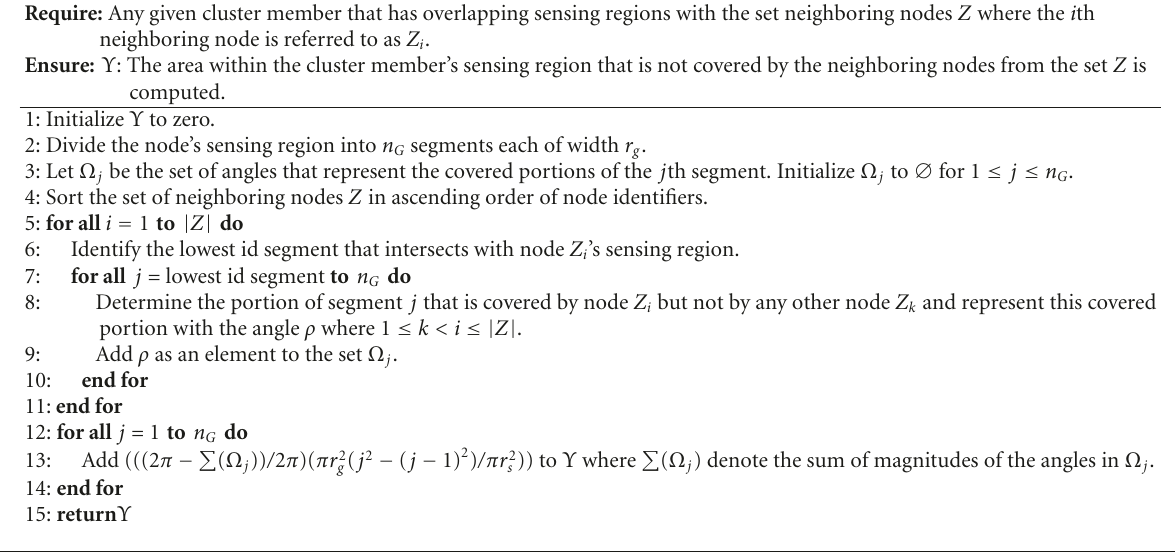
Algorithm 5: Coverage computation.